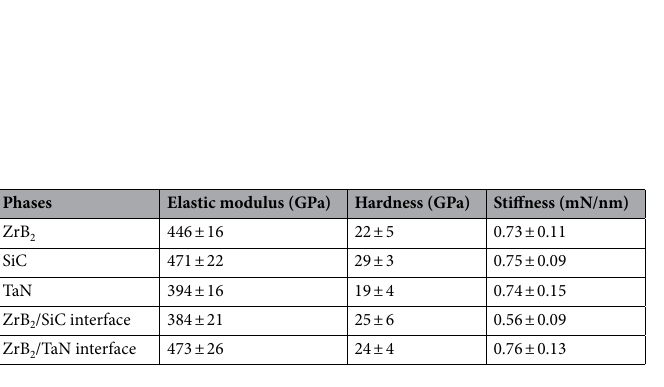
Table 1. Elastic modulus, hardness, and stiffness of various